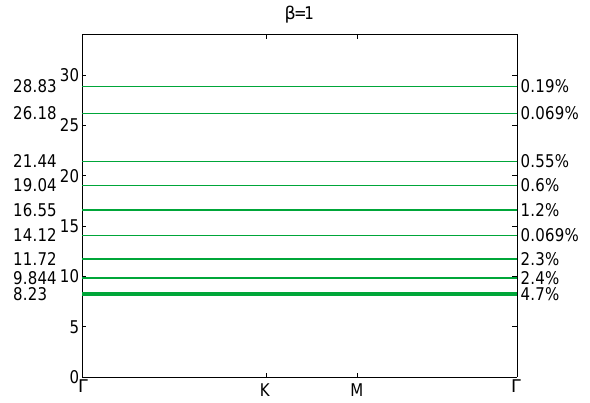
FIG. 8. (Color) Photonic band gaps within the lower 100 modes. For clarity, frequency bands are omitted; only the band gaps are plotted along with their gap (cid:3) midgap ratio.